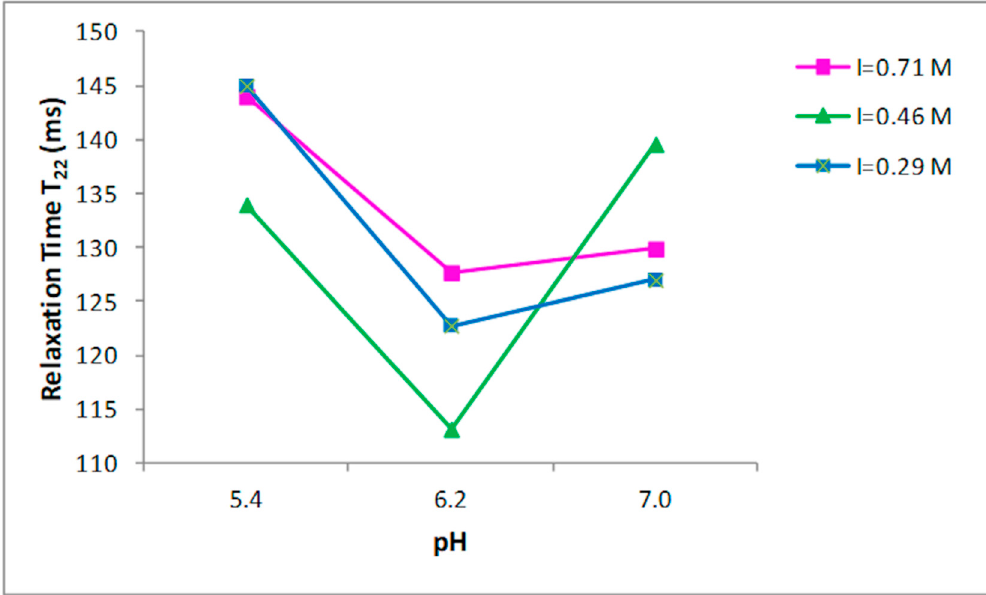
Figure 3. Relationship between the pH and T 22 relaxation time in collagen at different ionic strengths.